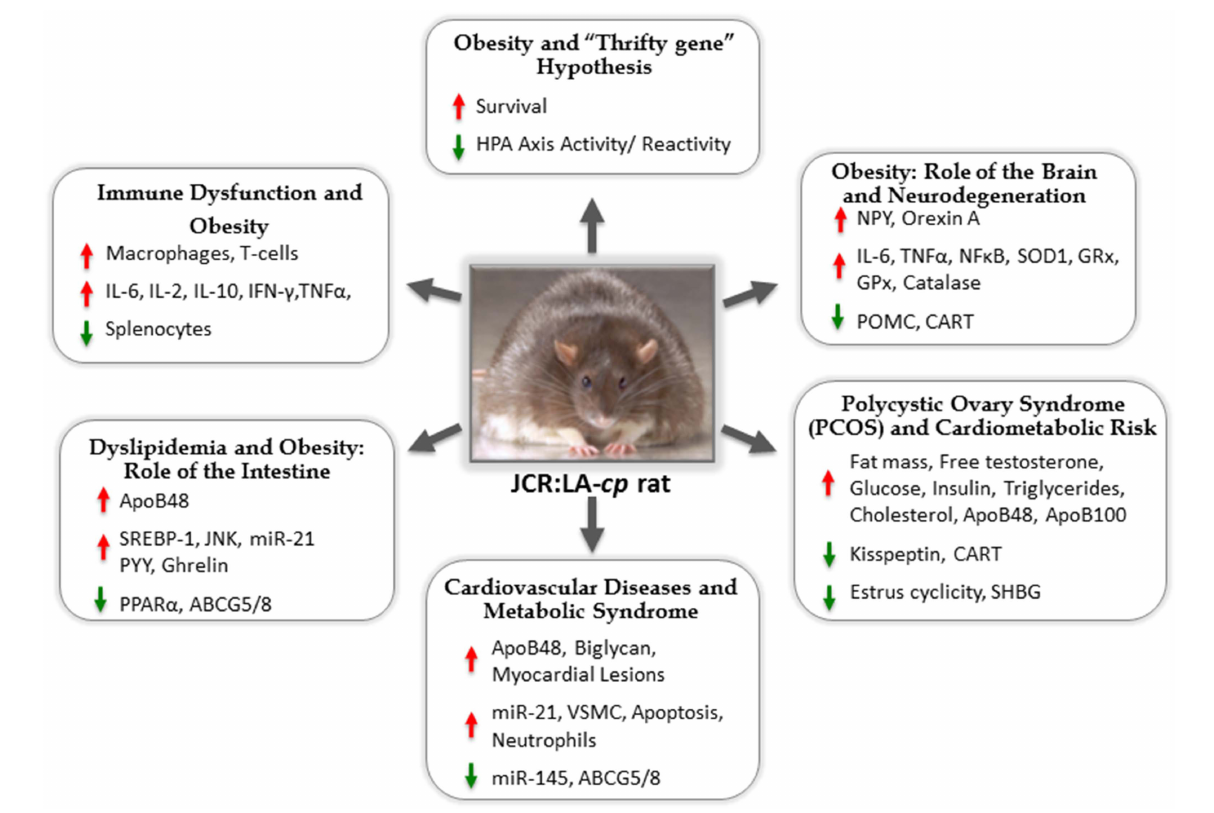
FiGURe 1 | The JCR:LA-cp rat: useful animal model for studies of metabolic syndrome and mechanisms of associated comorbidities .